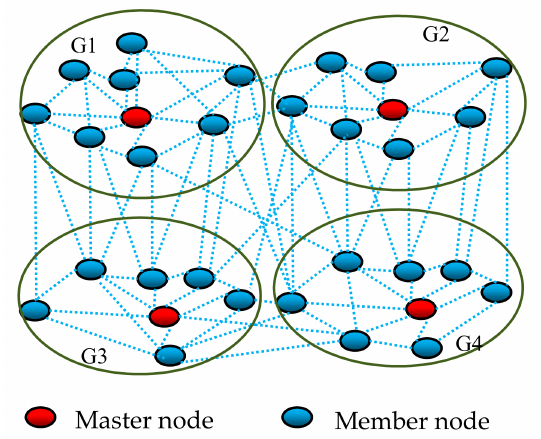
Figure 3. An example of the node